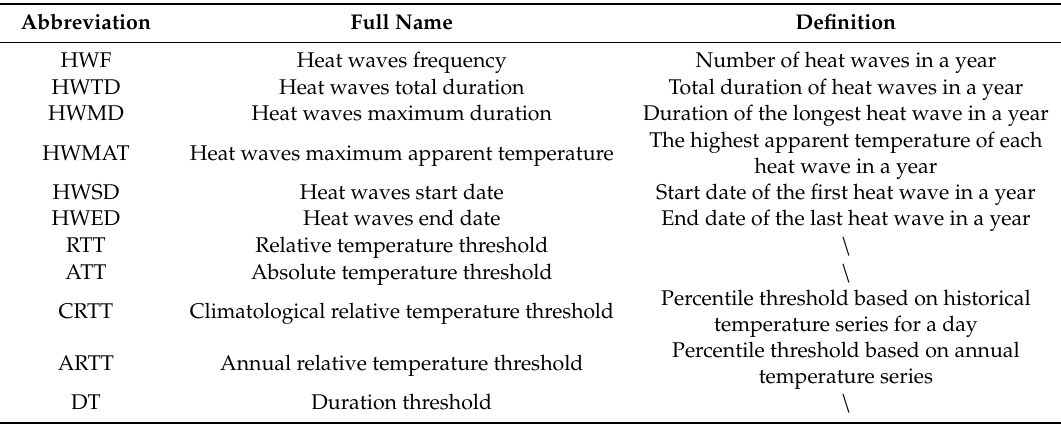
Table 1. Abbreviations and their full names and